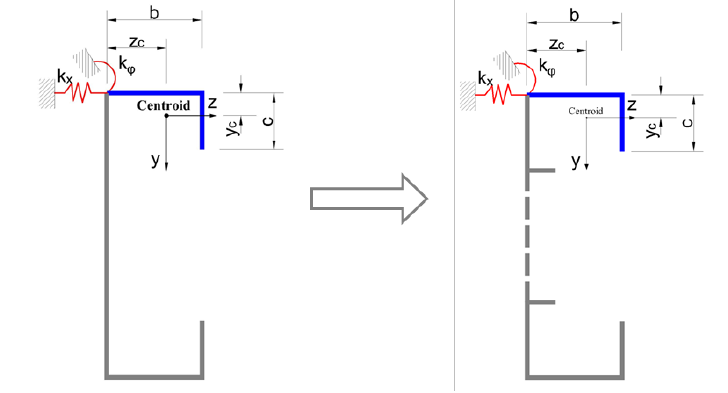
Figure 2. Analytical model for analysis of the flange – lip system, where it has been highlighted in blue.